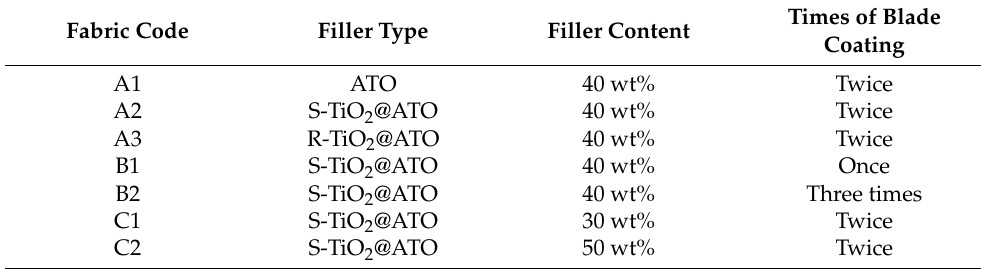
Figure 1. ( a ) Schematic of the manufacturing process of the coated nonwoven. ( b ) Microscopic surface texture of coatings with different TiO 2 @ATO powders. Table 1. Parameters of fabric